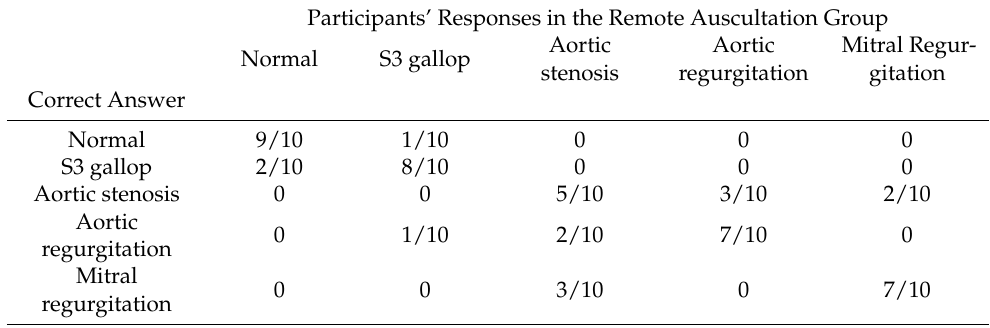
Table 4. Detailed answers in cardiac